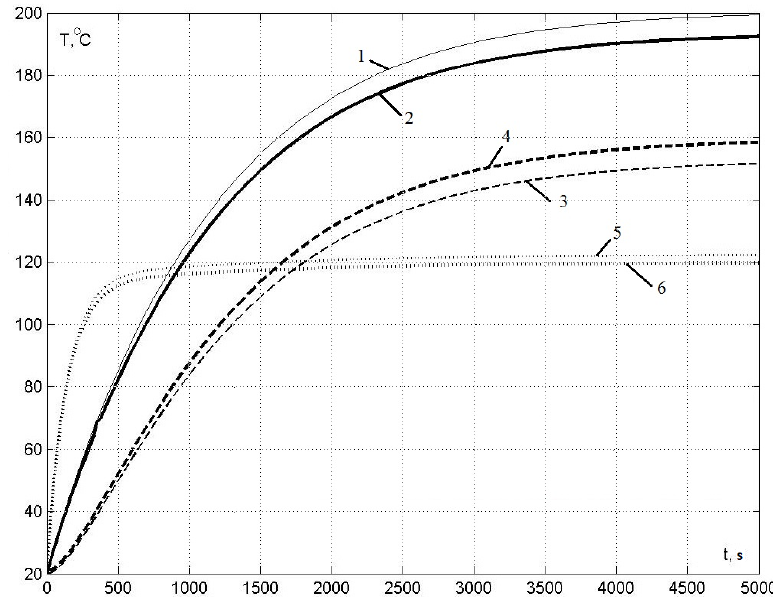
Figure 8. Comparison of calculation results with the FEM model. 1—primary winding average temperature; 2—primary winding average temperature (FEM); 3—primary magnetic core average temperature; 4—primary magnetic core average temperature (FEM); 5—secondary conductive plate average temperature; 6—secondary conductive plate average temperature (FEM).